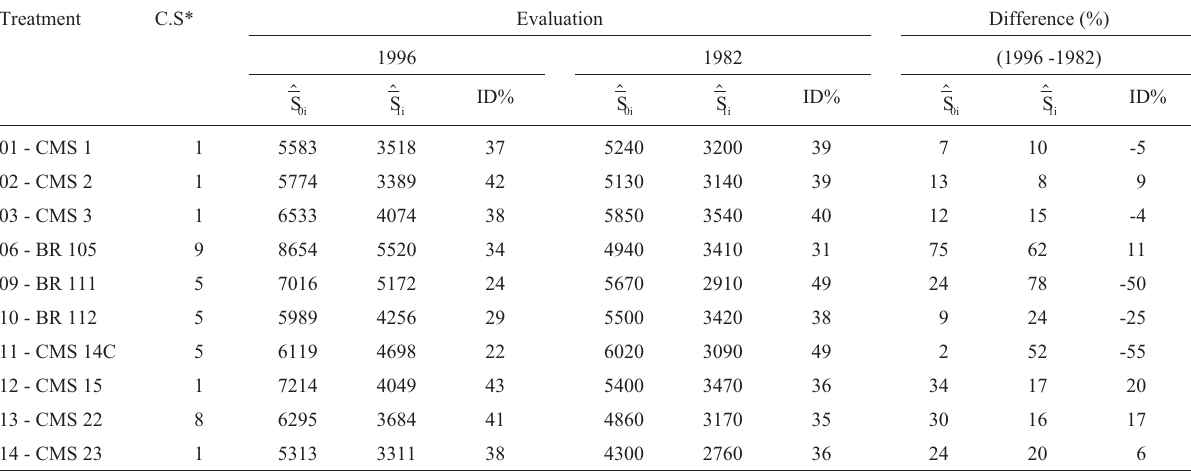
TableV -Changesinearweightmeanandinpercentageofinbreedingdepressionofthe10populationsafteronegenerationofselfingcomparedwiththe results obtained by Vianna et al . (1982) at Sete Lagoas, MG.